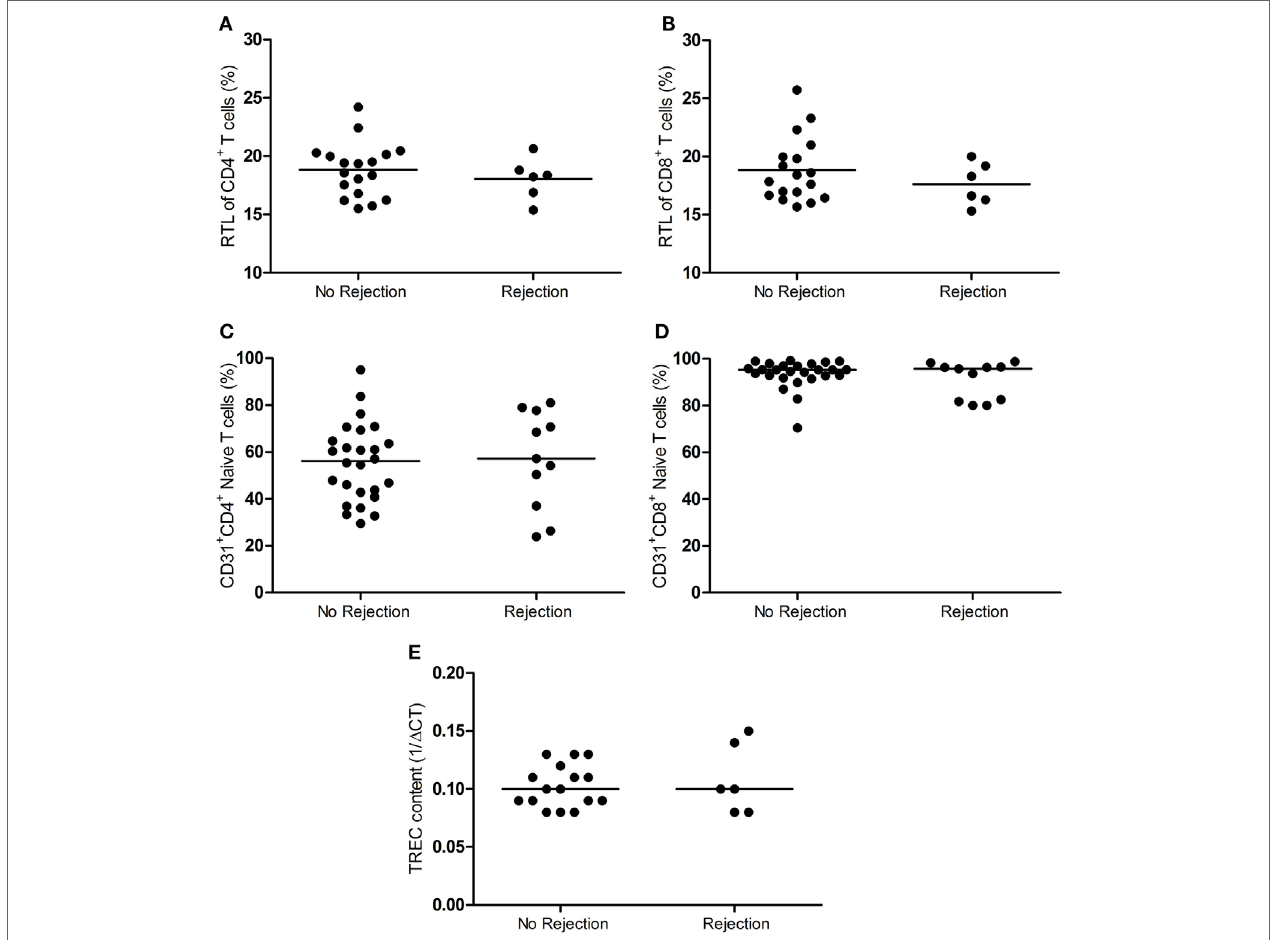
FigUre 3 | RTL, RTE frequency and TREC content in the lymph node between rejection and no rejection groups. The RTL of (a) CD4 + T cells and (B) CD8 + (T cells) within the lymph nodes between the no rejection and rejection groups are shown. Frequencies of (c) CD4 + and (D) CD8 + RTEs (CD31 + naïve T cells) within the lymph nodes between the no rejection and rejection group are shown. (e) The TREC content (1/ Δ CT) within the lymph nodes between the no rejection and rejection group is shown. Data are shown as individual points and medians. Significant differences were calculated and shown (* p < 0.05, ** p ≤ 0.01, *** p ≤ 0.001). RTEs, recent thymic emigrants; RTL, relative telomere length; TREC, T-cell receptor excision